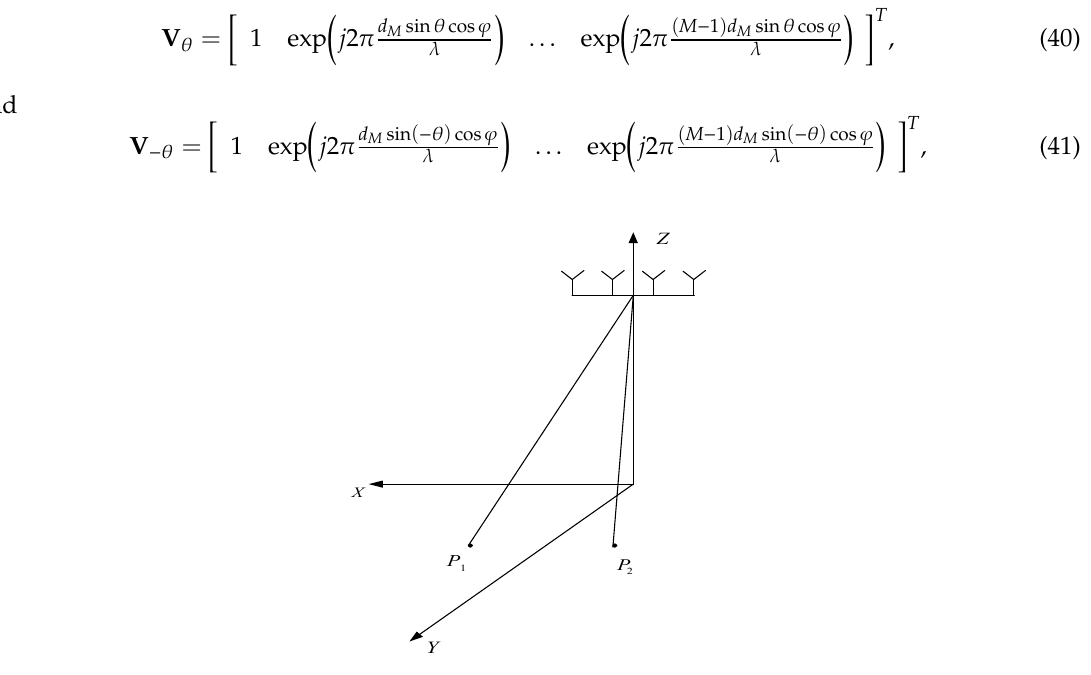
Figure 4. Geometry of the forward-looking SAR.